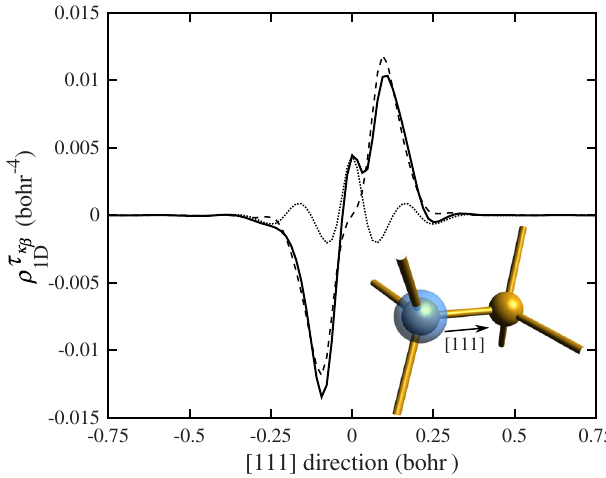
FIG. 1. Electron-density response to an atomic displacement along the [111] direction in bulk Si (solid line). Its symmetric (dotted line) and antisymmetric (dashed line) parts are also plotted. The first-order density is averaged in plane. The origin of the abscissas coincides with the position of the atomic sublattice highlighted in the